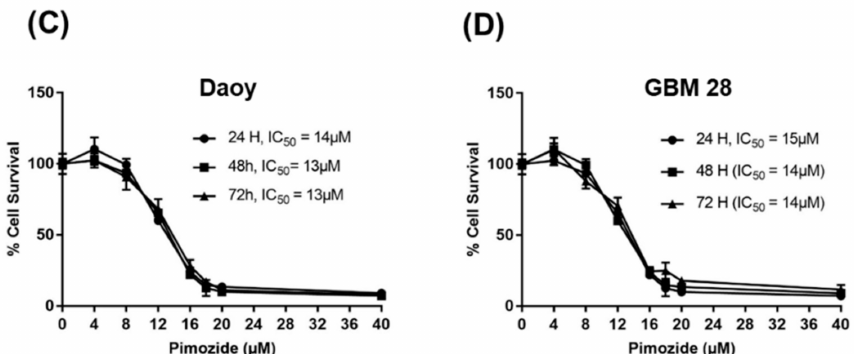
Figure 2. Pimozide suppresses the survival of brain tumor cells. ( A ) U-87 MG, ( B ) U-251 MG, ( C ) Daoy, and ( D ) GBM 28 cells were treated with di ff erent concentrations of pimozide for 24, 48, and 72 h. Cell survival was measured using Sulforhodamine B assay to estimate the IC 50 values. The experiment was repeated three times with eight replicates in each